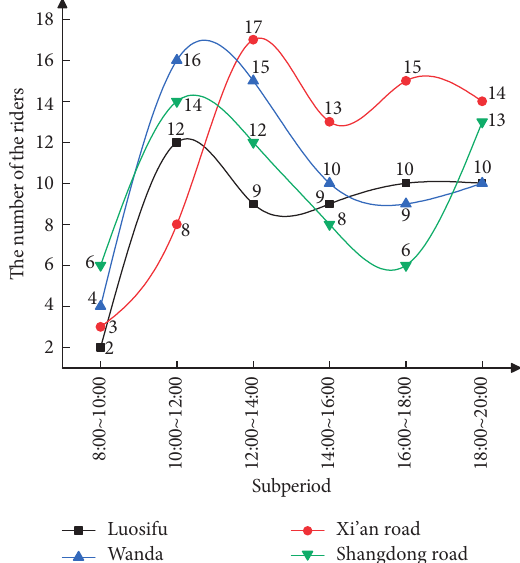
Figure 6: Statistical chart of transport capacity demand in each subperiod of the business